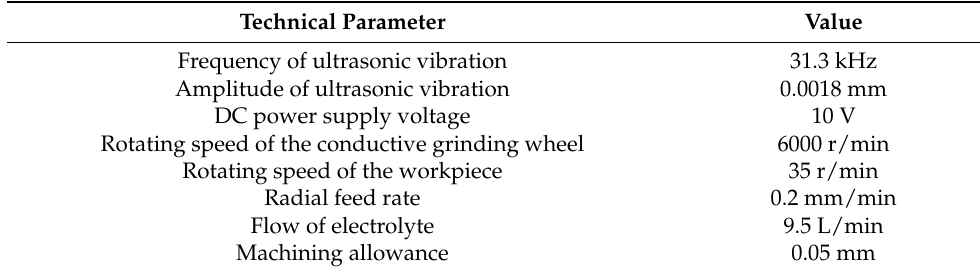
Table 3. Process parameters of the ICUAECG experiment.